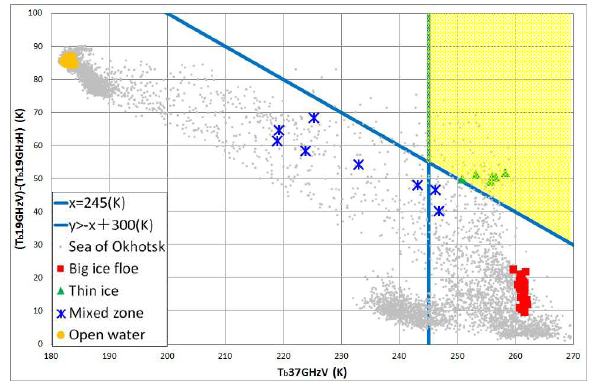
Figure 10. Scatter plots of (19GHzV – 19GHzH) Vs 19G H polarization (Sea of Okhotsk, February 23, 2014)